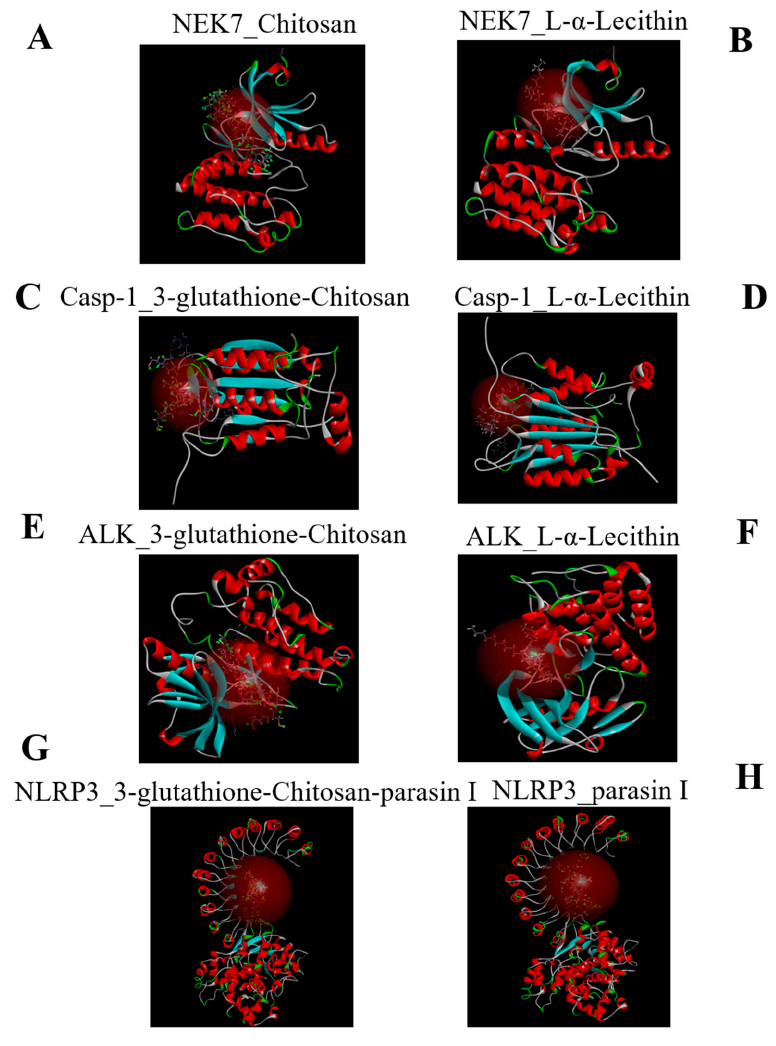
Figure 1. Stereoview of the minimum energy docked conformation of NEK7 with chitosan. ( A ) NEK7 with L- α -lecithin ( B ) casp-1 with 3-glutathione with chitosan ( C ) casp-1 with L- α -lecithin ( D ) ALK with 3-glutathione-chitosan ( E ) ALK with L- α -lecithin ( F ) 6NPY with 3-glutathione-chitosan-parasin I ( G ) 6NPY with parasin I ( H ) during the molecular docking. Furthermore, the thiolated-chitosan and parasin I can both dock with NLRP3. The lowest binding affinities and binding force types of all dockings are shown in Table 1. The lipid/peptide adduct will increase the interaction between NLRP3 and parasin There were no hydrogen bonds in any binding. The interactions between NLRP3 and 3- glutathione-chitosan-parasin I ( − 167 kcal/mol) were predicted to be stronger than that of NLRP3 and parasin I ( − 138 kcal/mol).